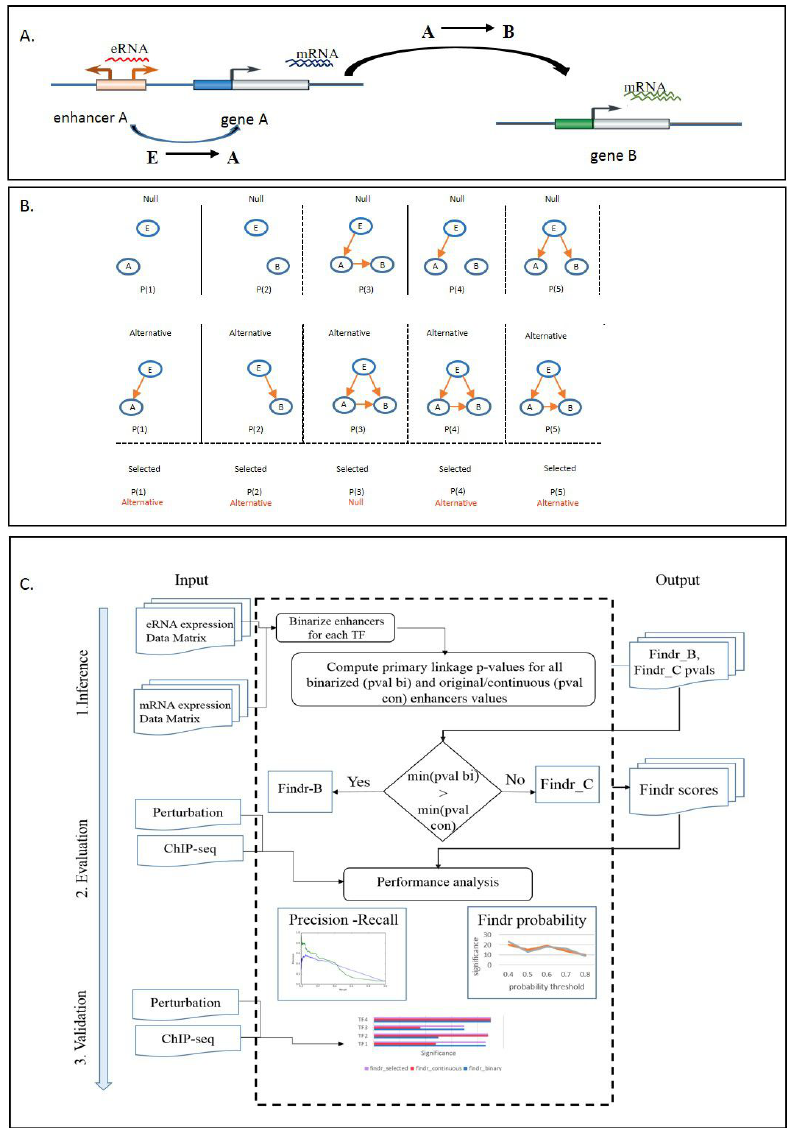
Figure 1. Overview of the Findr framework. ( A ) The schematic representation of causal gene regulatory network inference using enhancer activity as a causal anchor. ( B ) Five statistical tests used by Findr for causal inference. ( C ) Workflow of the Findr-A framework. eRNA, enhancer RNA; TF, transcription factor; B, binary; C,